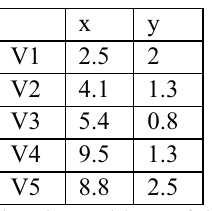
Table: 1 shows that the positions of the sensor nodes The distance membership calculation for V1 with respect to C1 and C2 is given